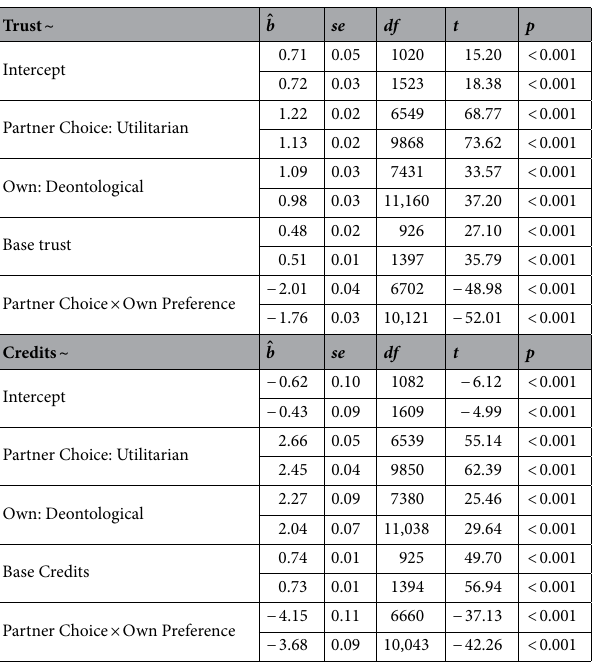
Table 2. Fixed effects for the replication analyses. Categorical variables were dummy coded. Top line displays the result using the sample with preregistered exclusions. Bottom line displays results using the full sample. Coding of the dummy variables: (1) Partner choice: 1 = Utilitarian, 0 = Deontological; (2) Own preference (i.e., participant’s own preference): 0 = Utilitarian, 1 =